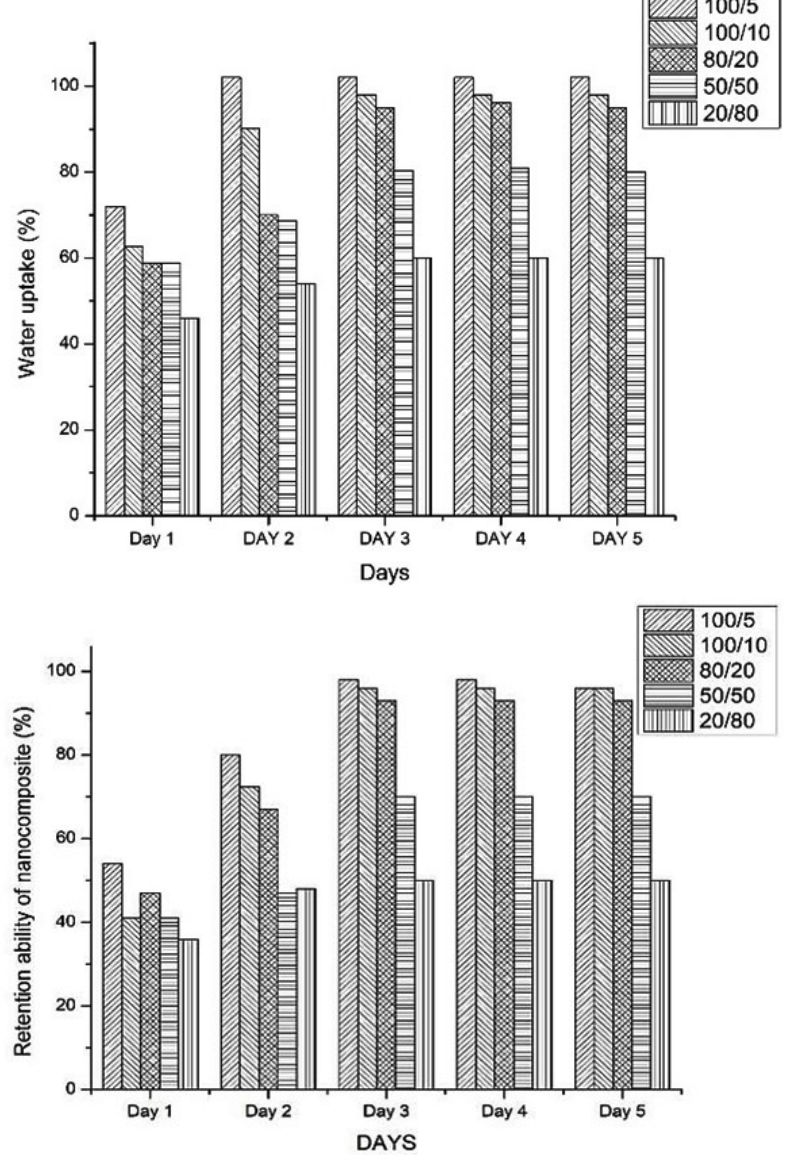
Fig. 2. Trend of water uptake (2a) and retention ability (2b) of nanocomposite with different ratios of Chitosan/ Hydroxyapatite: The nanocomposite absorbed more water than their weight and scaffold showed maximum capacity to retain the absorbed